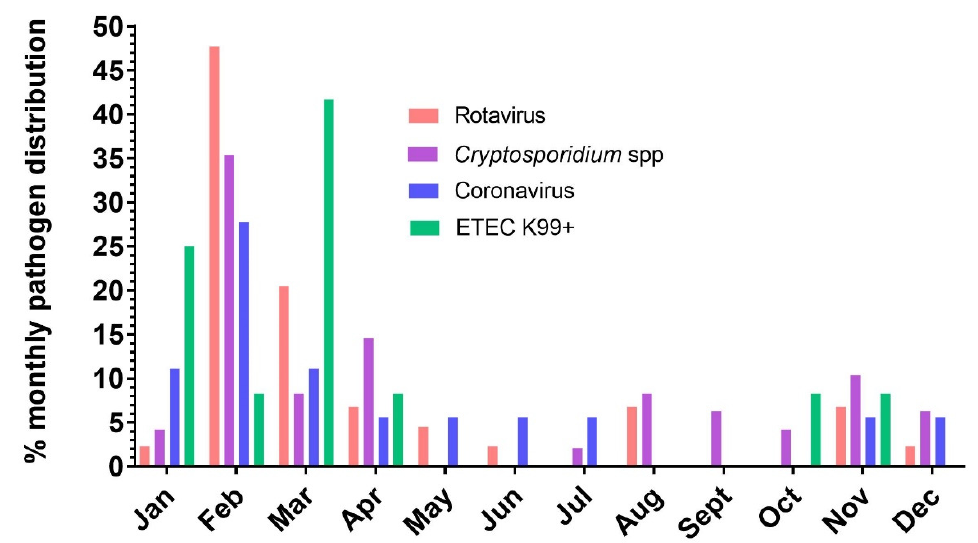
Figure 3. Bar chart: the percentage monthly distribution of pathogens excreted by neonatal calves with diarrhea admitted to the with diarrhea admitted to the ICU.